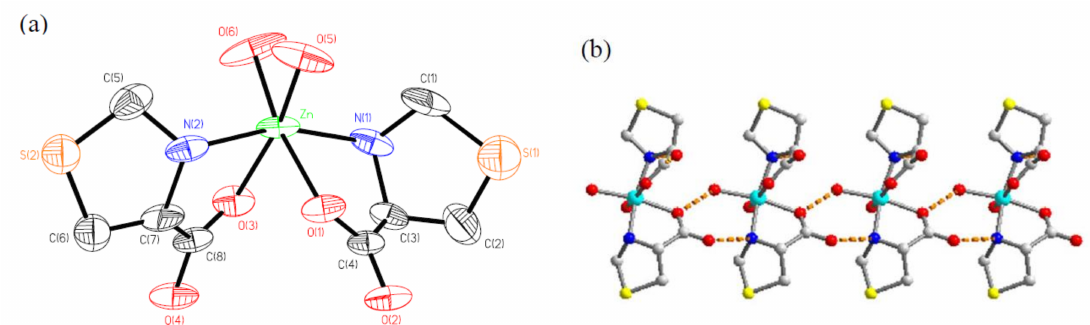
Figure 2. Structures of 1 : ( a ) coordination environment of the Zn(II) ion; ( b ) a simplified 1D chain connected by hydrogen bonding interactions (orange dash lines).